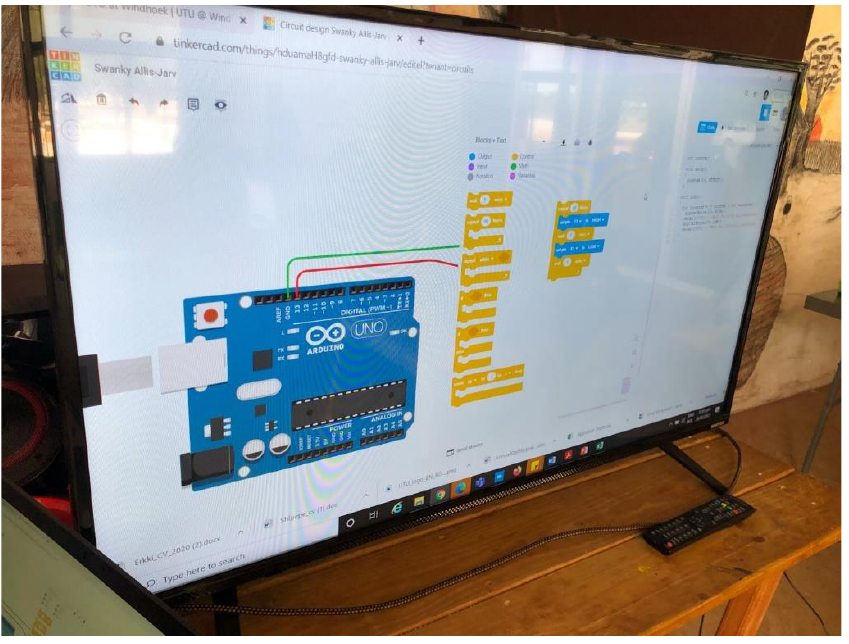
Figure 9. Loop structure on Tinkercad.